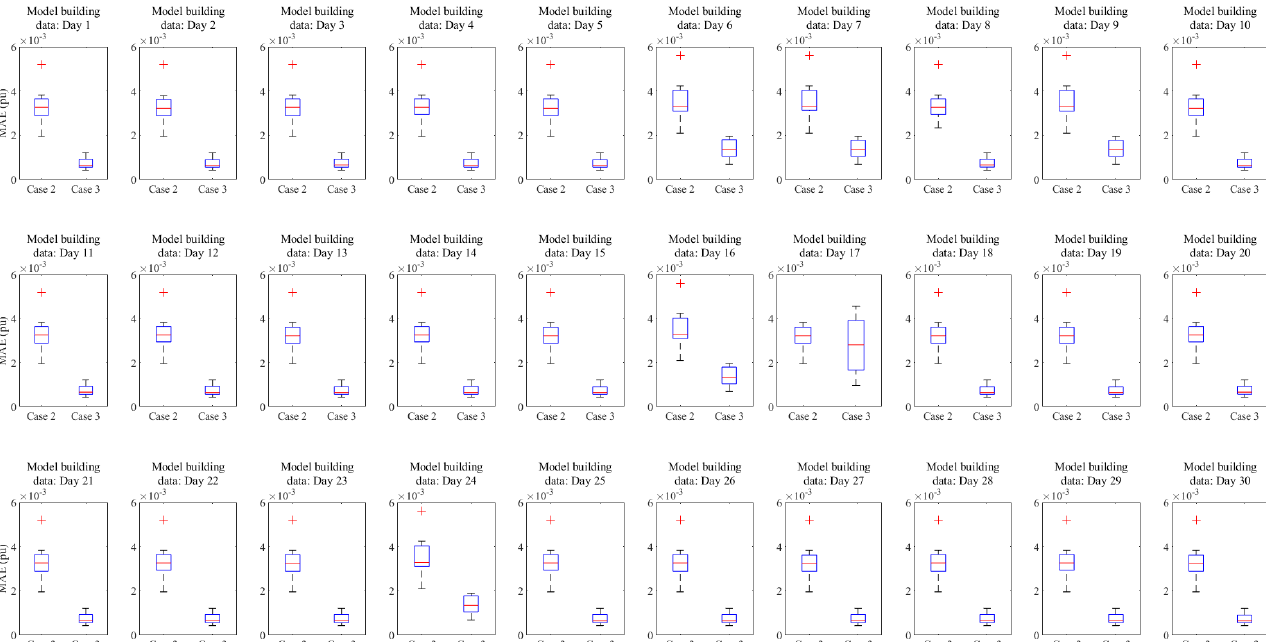
Figure 8. Boxplot of mean absolute error (MAE) in the voltage of Case 2 (left bars) and Case 3 (right bar) over Case 1. The result of each case study, which uses each Day 1 to 30 as model-building data, is compared. The implementation of the proposed method (left bar to right bar) reduces the MAE in the voltage in almost all cases. The result whose model-building data are Day 17 reveals the PV profile with small generation (see Figure 4a) should not be used for the model-building data.